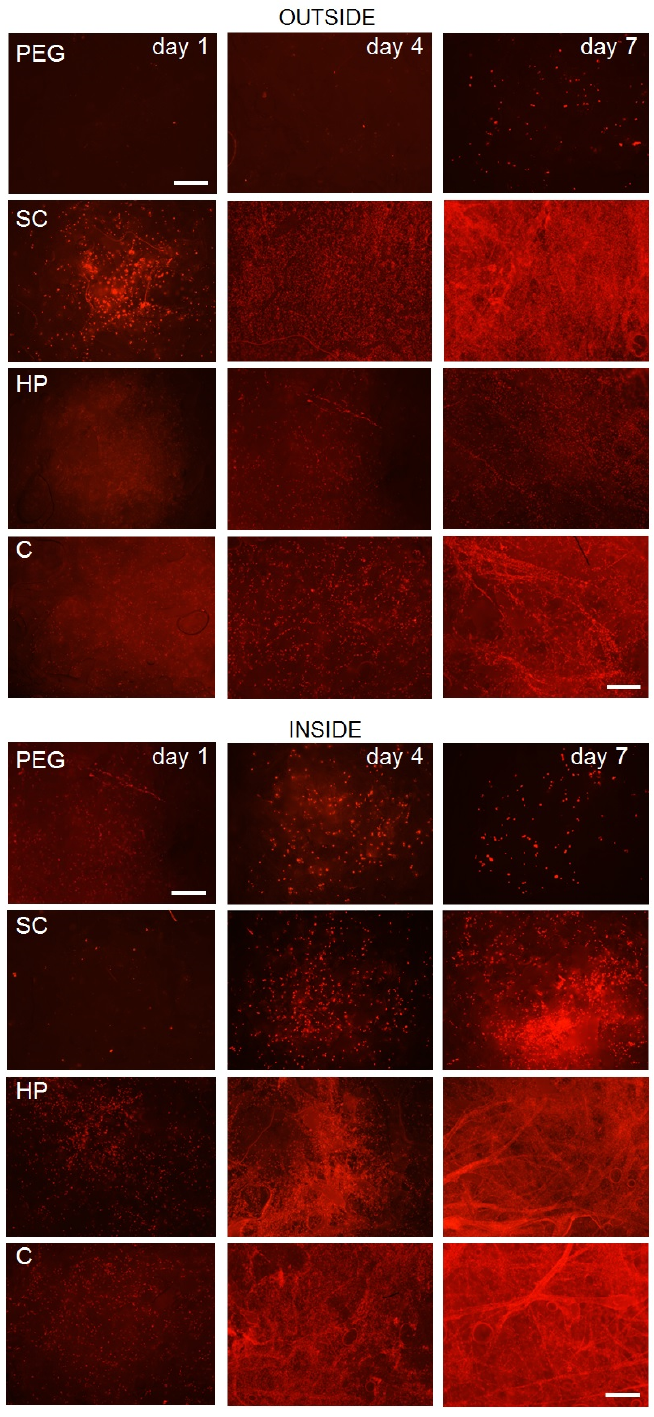
Figure 7. Images of fluorescence microscopy of bone osteoblasts on scaffolds on the 1st, 4th and 7th test days comparing the effect of the internal printing of various bioinks on the viability of human osteoblasts—propidium iodide staining. The images consist of shots taken by microscope auto-focus in z-axis, 1 µ m step; the scale is 500 µ m. The top section shows surface cell proliferation—OUTSIDE. The bottom part shows internal cell proliferation (3 mm under the surface)—INSIDE. C—Hydrogel with incorporated collagen, HP—Hydrogel with incorporated heparin, PEG—polyethylene glycol photosensitive hydrogel, SC—scaffold with conventionally seeded